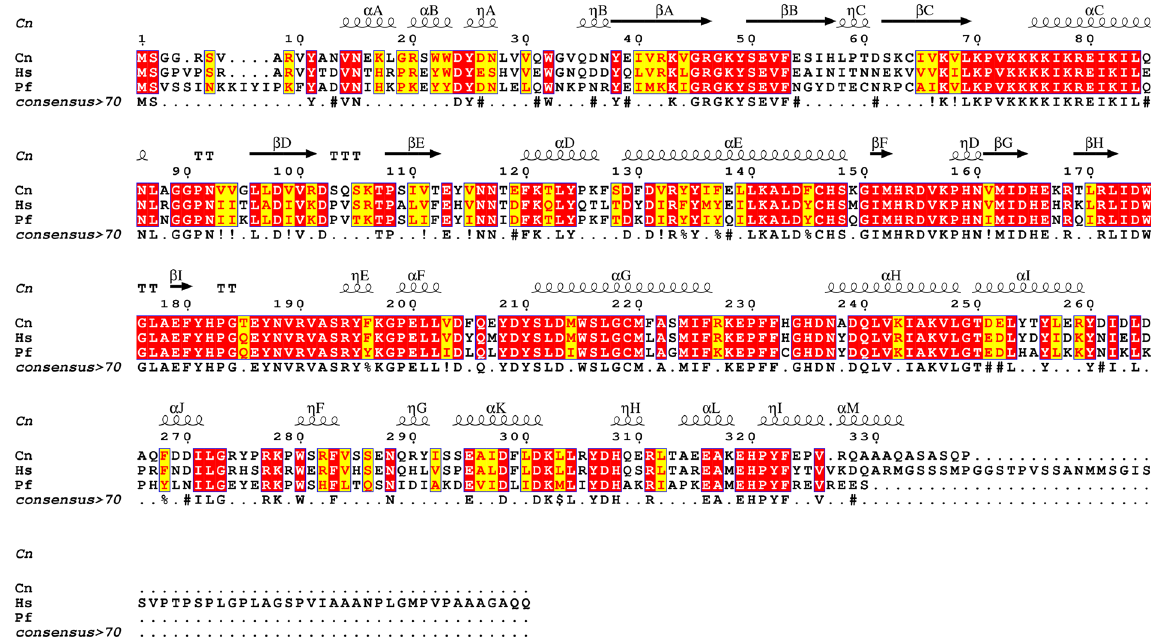
Figure 3. Alignment of CK2 α sequences between C . neoformans (Cn), H . sapie ns (Hs) and P . falciparum (Pf) with the secondary structure of cn Cka1. Identical residues are shown in red and conserved residues are shown in yellow. This figure was produced using ESPript 3 . 0 (http://espript.ibcp.fr/) 22